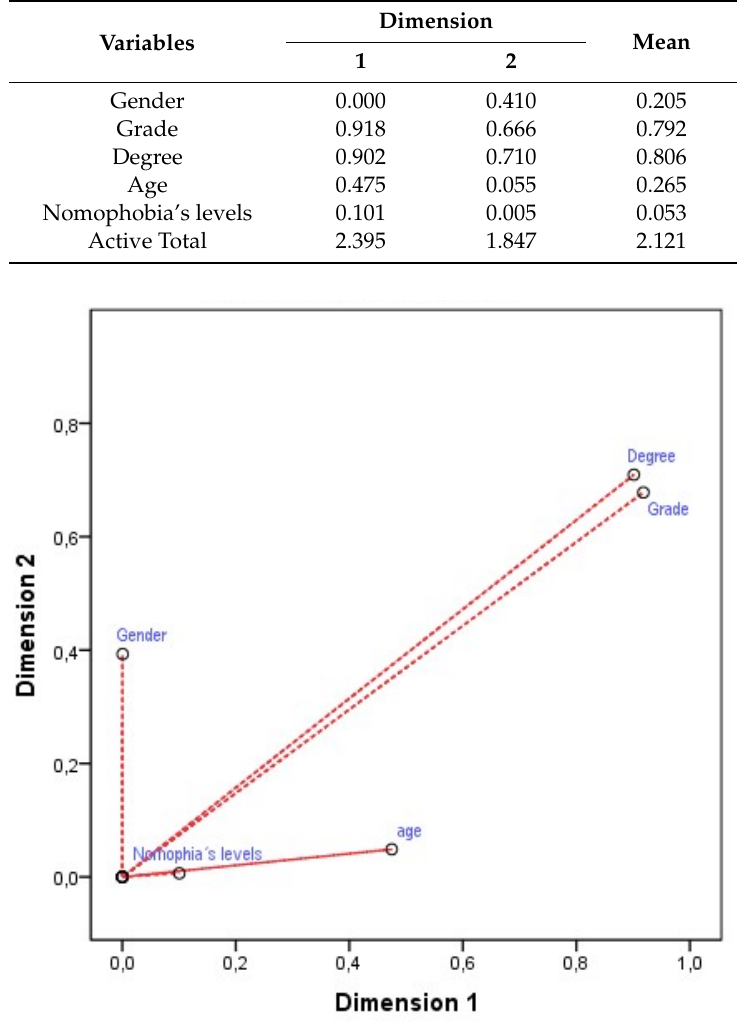
Figure 2. Discrimination measures of the variables.